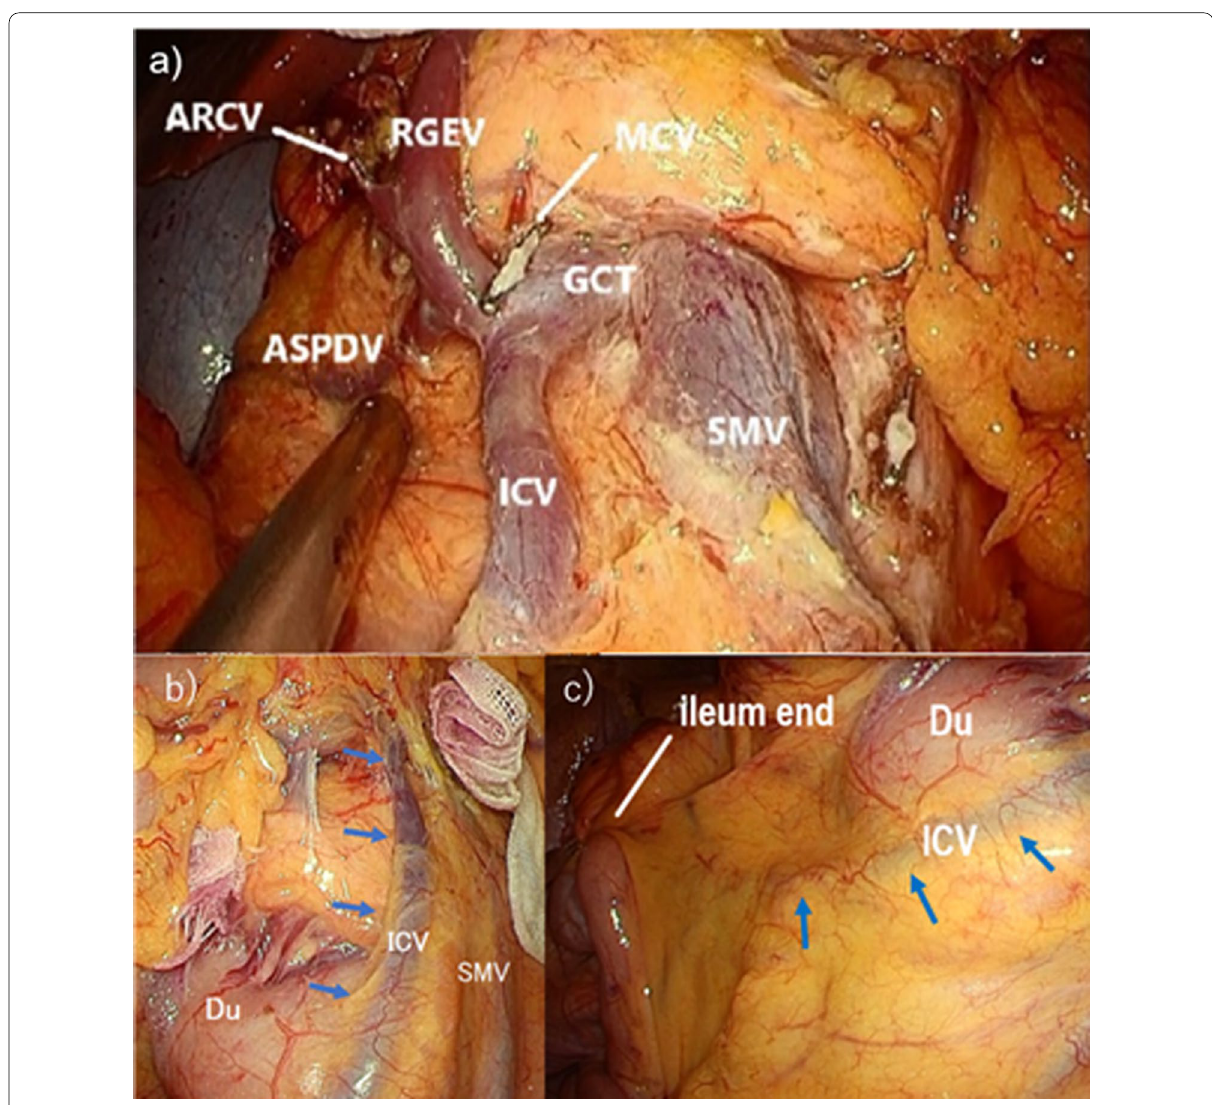
Fig. 4 Intraoperative findings. a The ileocolic vein (ICV) ran on the ventral side of the duodenum (blue arrow). b The ICV ran toward to the GCT on the ventral side of the duodenum and pancreatic head (blue arrow). c Situs after lymph node dissection. The ICV drained into the gastrocolic trunk (GCT) with the anterior superior pancreaticoduodenal vein (ASPDV), middle colic vein (MCV) and right gastroepiploic vein